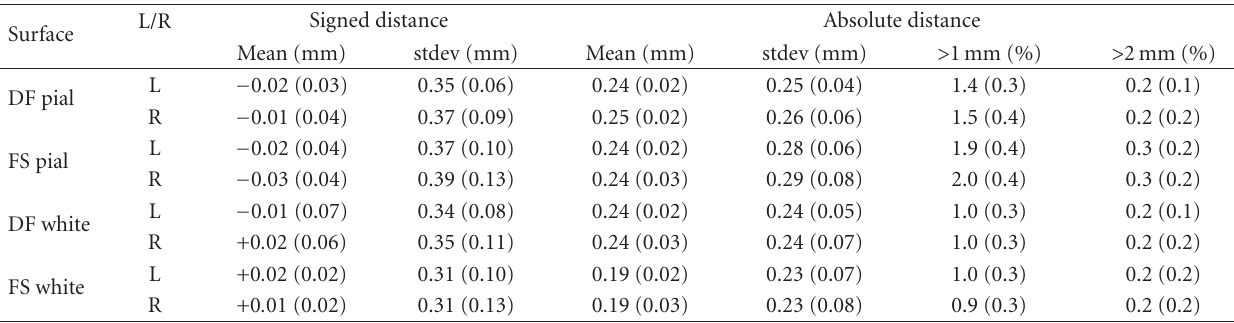
Table 1: Precision analysis: summary of the group-average statistics for the signed distance (SD) and absolute distance (AD) measure (in mm) between test and retest surfaces (surface: DF—DELFMAP, FS—FreeSurfer; L/R: left/right hemisphere; mean: a group average of a